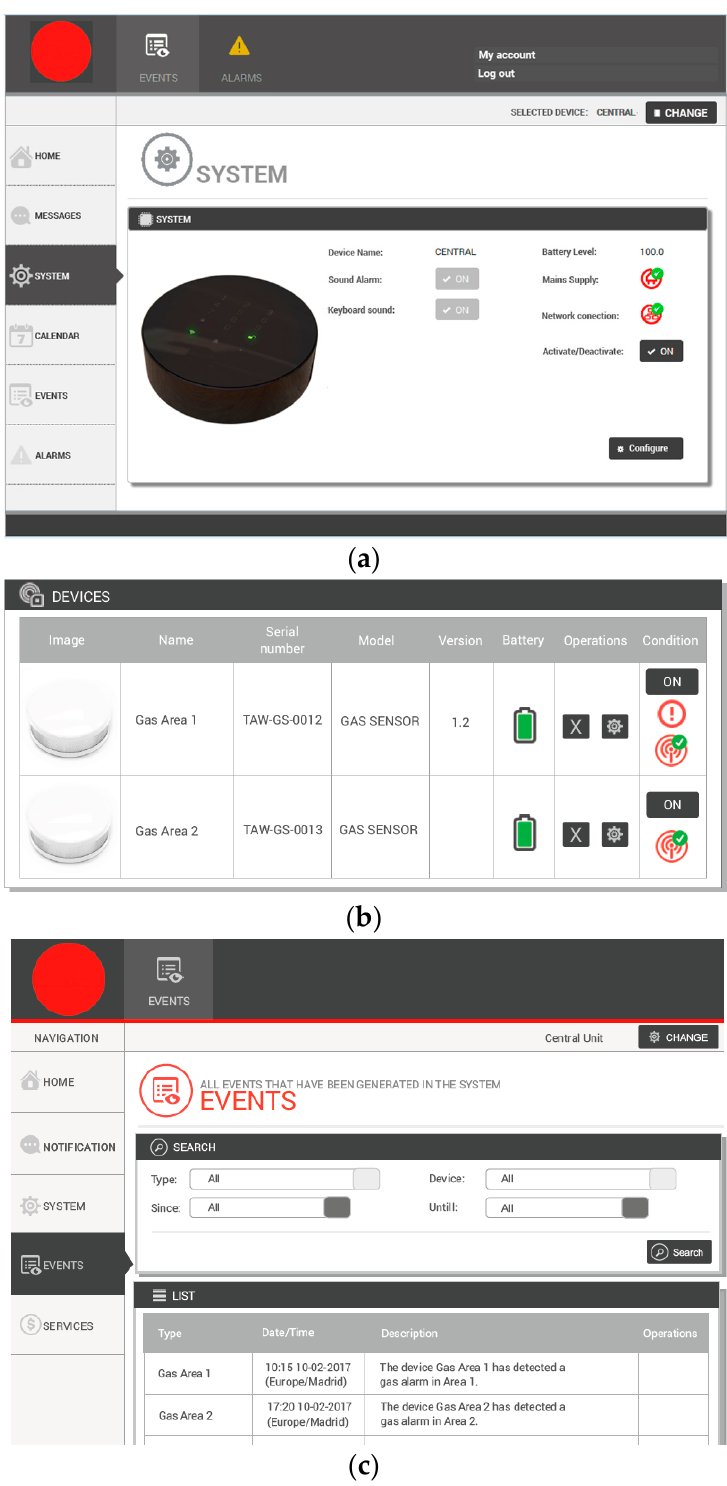
Figure 10. Main views of the monitoring application.